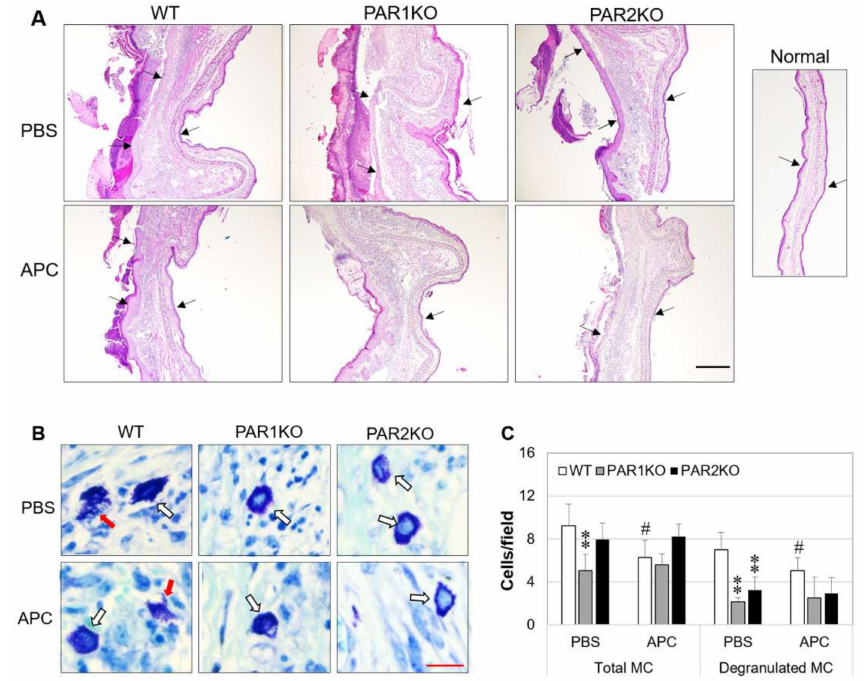
Figure 2. Histological features of DNFB-induced CHS in mice in response to APC therapy. Mice were euthanized at day 14 after DNFB challenge. Ear tissues were fixed, embedded, sectioned, and stained. ( A ) The representative images of ear skin tissues stained with hematoxylin and eosin. Arrows indicate epidermis. Scale bar: 500 µ m. ( B ) The representative images of mast cells (MC) in the ear skin tissues of CHS, stained with toluidine blue. White arrows indicate non-degranulated MC and red arrows degranulated MC. Scale bar: 30 µ m. ( C ) MC quantified in five random fields from each slide at 400 × magnification under a microscopy. Data shown on graph are means ± SD ( n = 8 for all groups). ** p < 0.01 vs. WT. # p < 0.05 vs. its own control